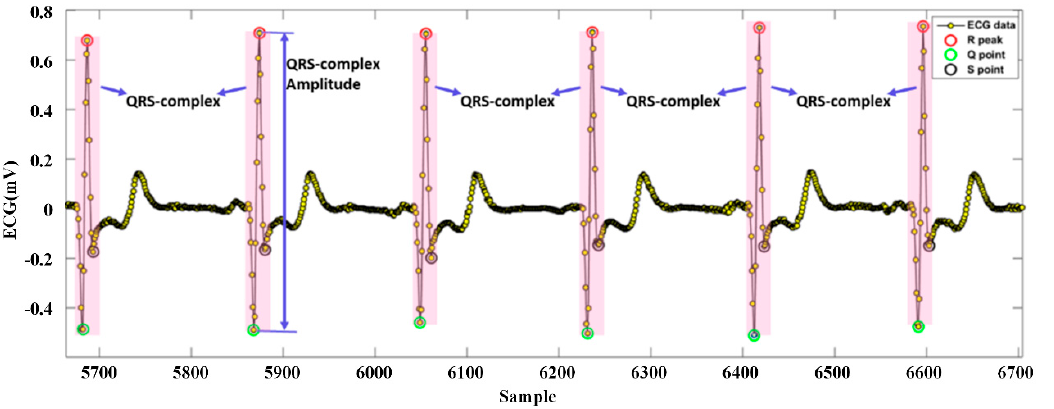
Figure 11. Example of QRS recognition.